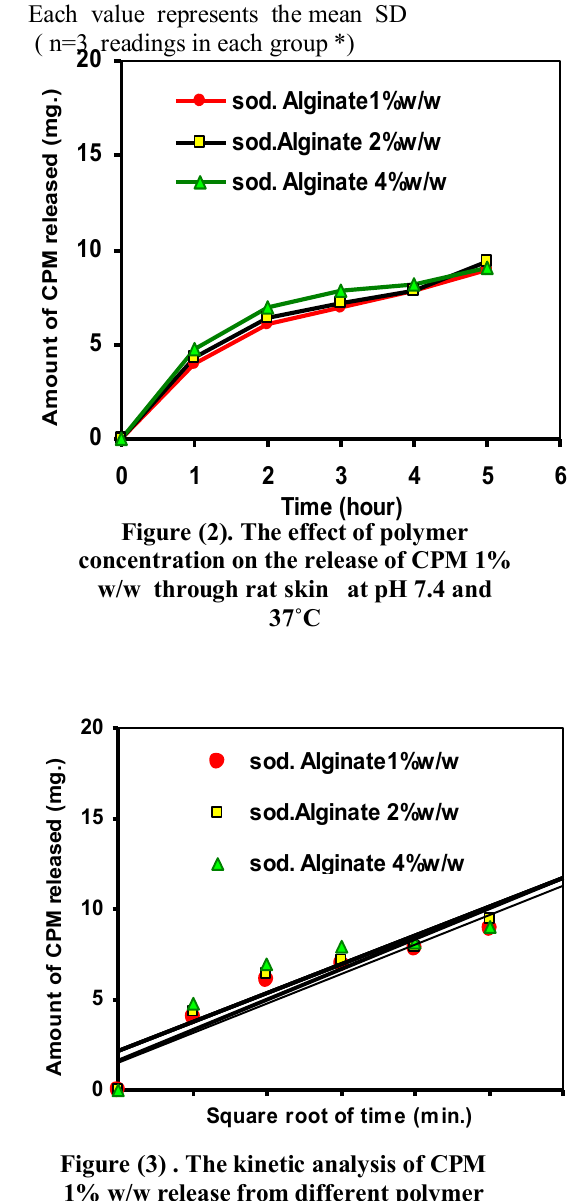
Figure (3) . The kinetic analysis of CPM 1% w/w release from different polymer concentration at pH 7.14 and